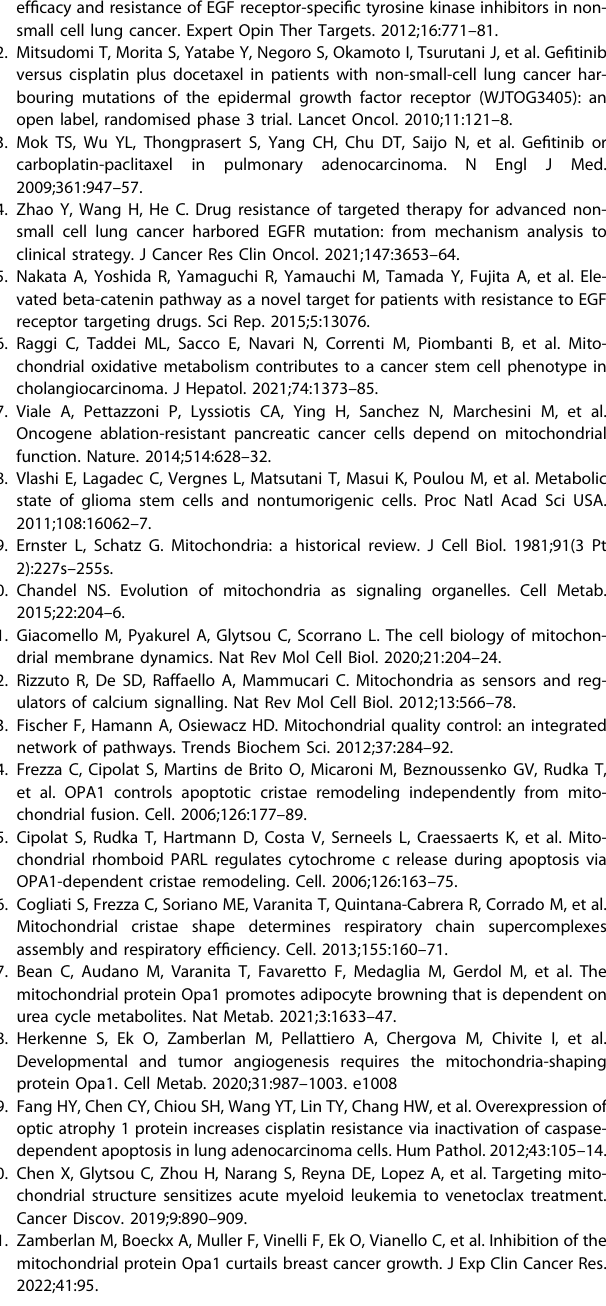
DATA AVAILABILITY Uncropped versions of the Western blots are available as original data fi les. The other datasets generated during and/or analyzed during the current study are available from the corresponding authors upon reasonable